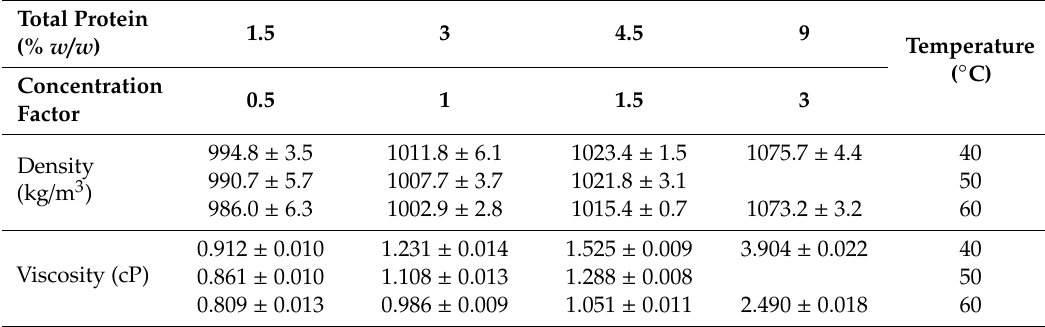
Table 2. Physico-chemical properties of the tested skim milk